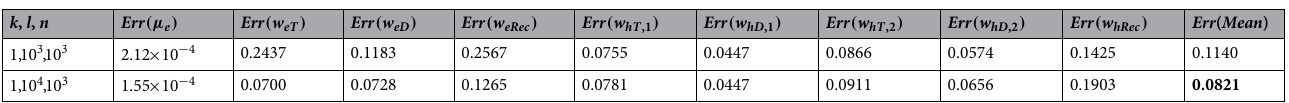
Table 1. Error values for Physical Model-1. Err (µ e ) , Err ( w eT ) , Err ( w eD ) and Err ( w eRec ) are the Error values in the drift, trapping, detrapping and recombination coefficients of the electrons respectively. Err ( w hT ,1 ) , Err ( w hD ,1 ) , Err ( w hT ,2 ) , Err ( w hD ,2 ) and Err ( w hRec ) are the error values in the trapping 1, detrapping 1, trapping 2, detrapping 2 and recombination coefficients of the holes respectively. Err ( Mean ) is the arithmetic mean of these error values. Significant values are in